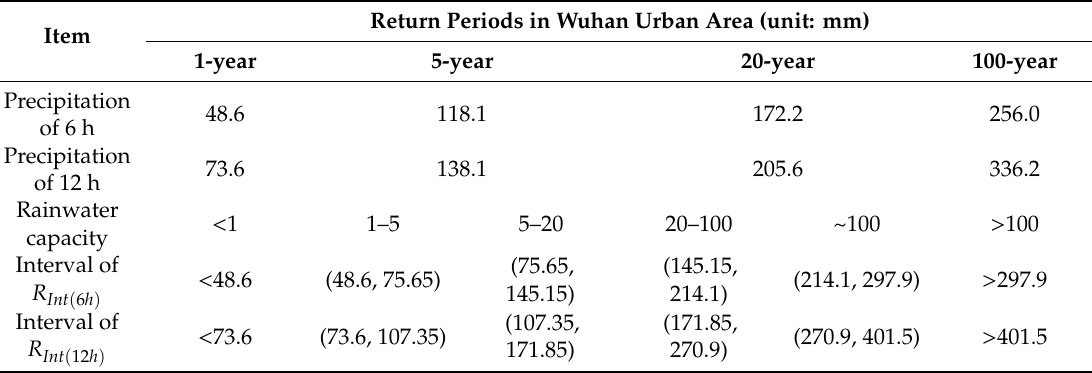
Table 5. The precipitation of six intervals corresponding to the four types of return period (unit: